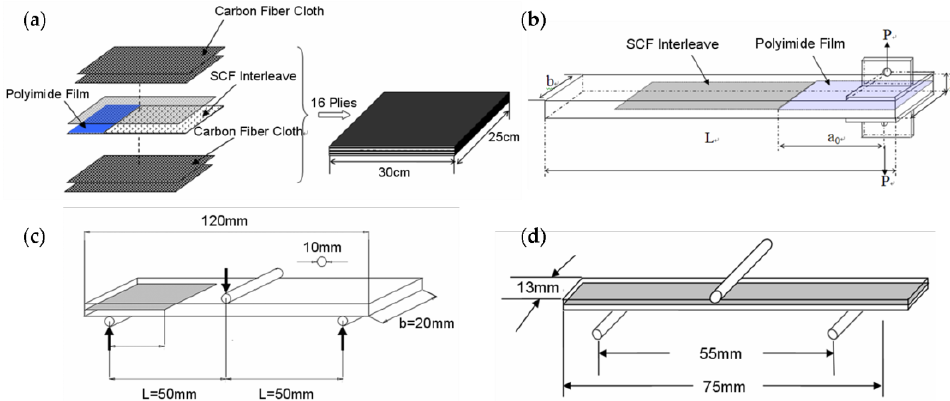
Figure 2. ( a ) Schematic for fabrication of non-woven carbon tissue (NWCT) interleaved laminates and the specimen geometry for ( b ) Double cantilever beam(DCB), ( c ) End Notched Flexure (ENF), ( d ) Flexture properties tests.